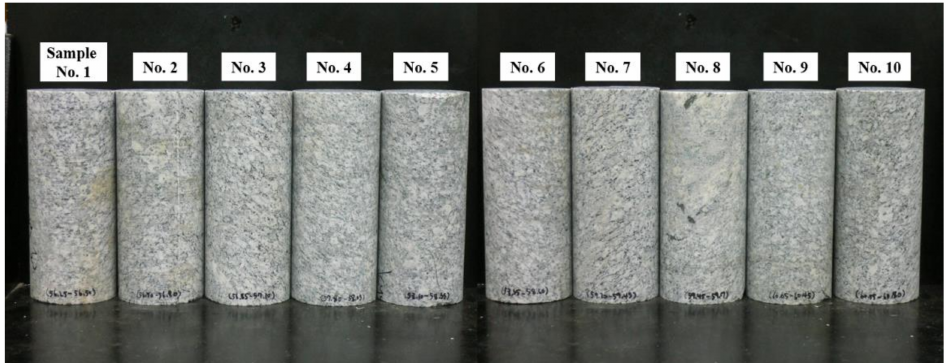
Figure 2. Korea Underground Research Tunnel (KURT) located in Daejeon, South Korea. This facility was constructed for the purpose of simulating the radioactive waste disposal repository.